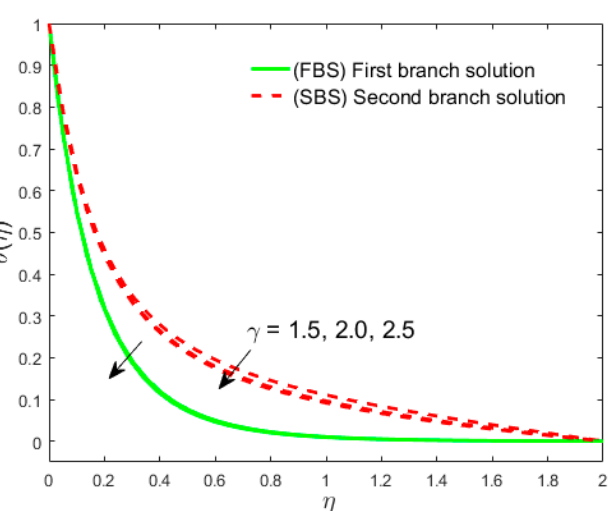
Figure 11. The impact of M on θ ( η ) .